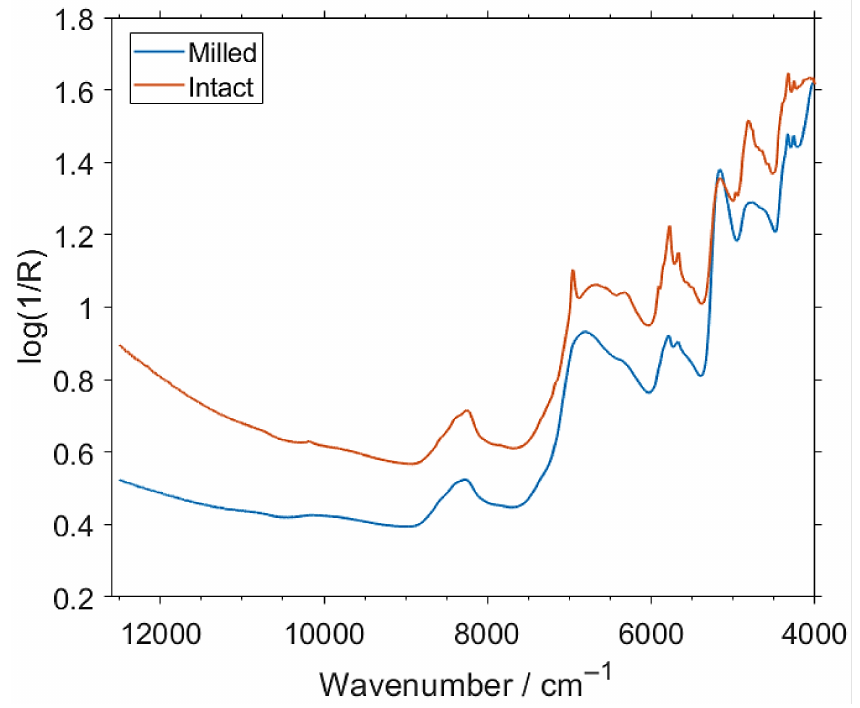
Figure 2. Exemplary spectra (prior any pretreatments) of intact and milled insect protein bars measured by the benchtop spectrometer Büchi NIRFlex